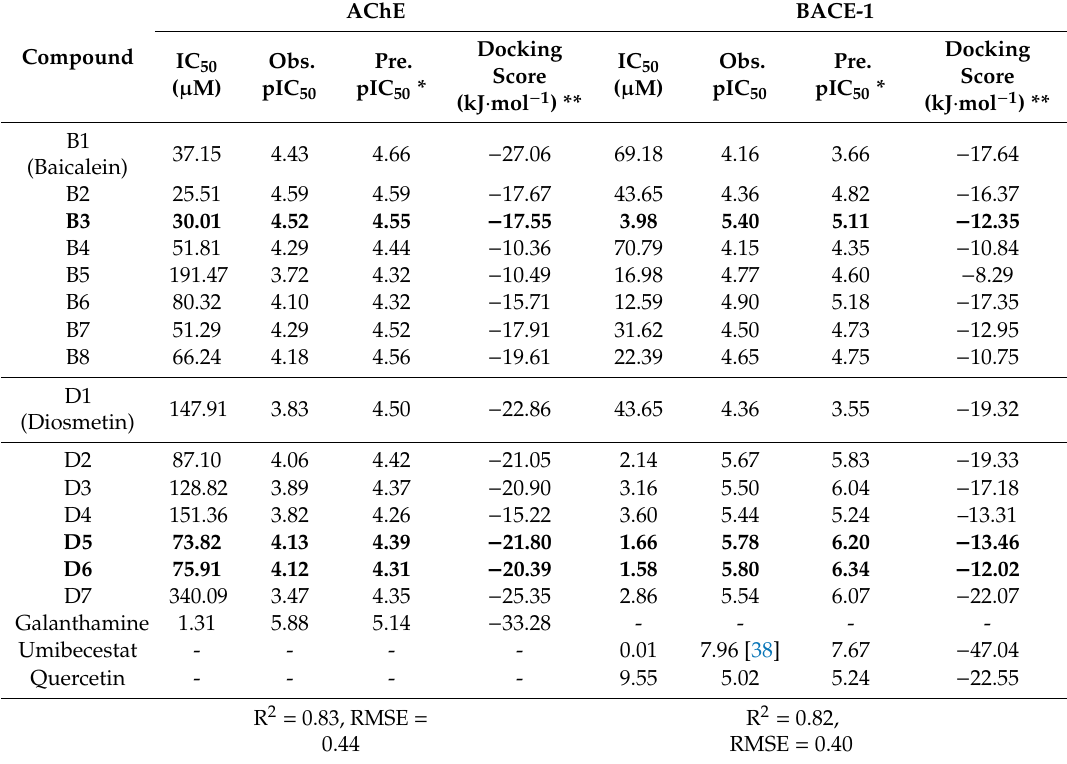
Table 1. Acetylcholinesterase (AChE) and β -secretase (BACE-1) inhibitory activities and docking scores of the synthesized flavone derivatives.